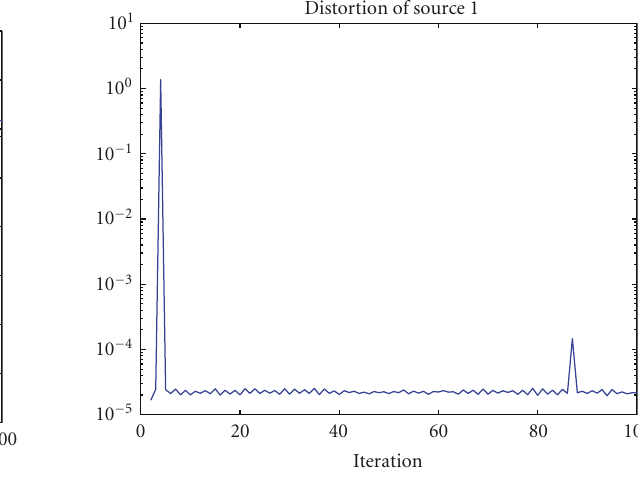
Figure 7: Distortion of source 1.